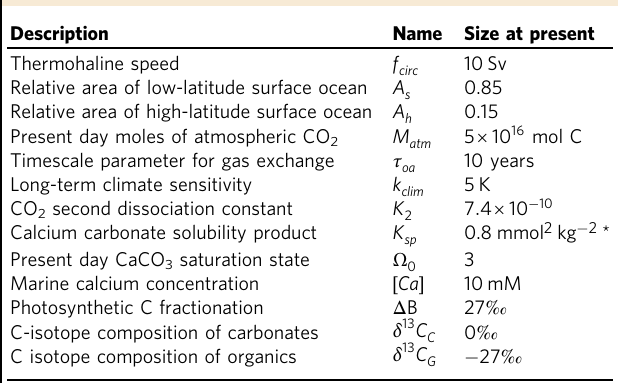
Table 3 Fixed model